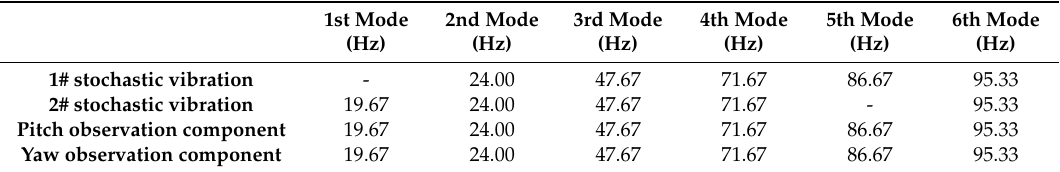
Table 4. Comparison results at Ma =